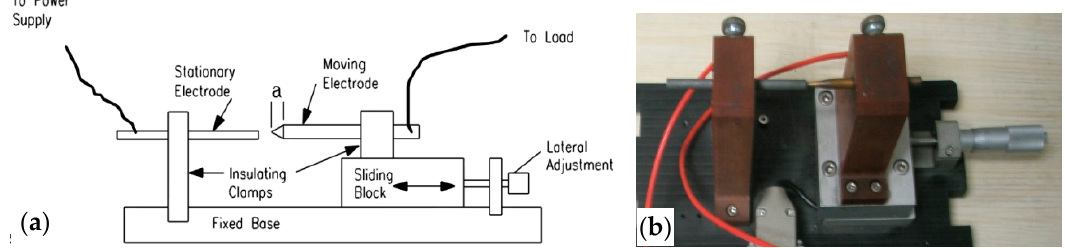
Figure 2. Experimental platform for electrical fire research: ( a ) schematic; ( b , c ) actual platform.